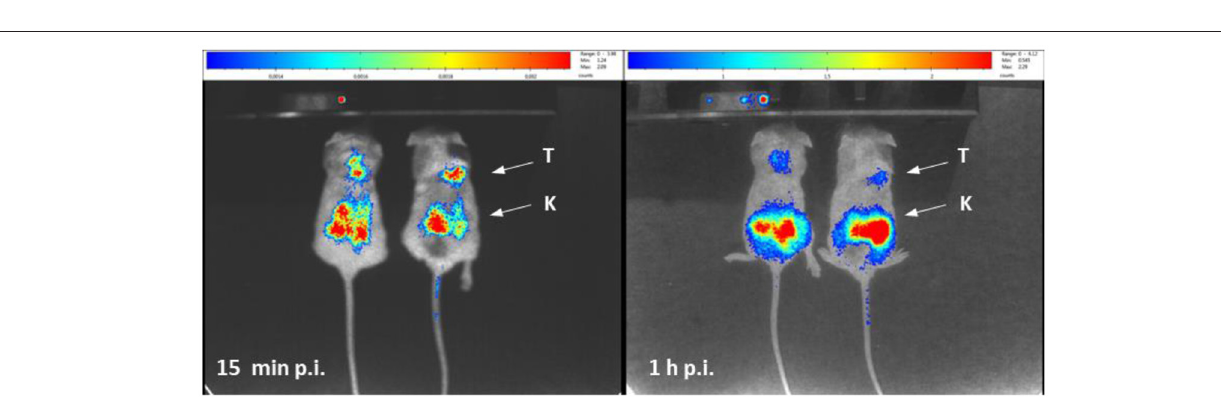
FIGURE 4 | Cherenkov luminescence images at different time points (15min, 1h) of prostate cancer PC3 tumor-bearing mice administered first with AR-PEG4-TCO (1 nmol) and then, after 4h, with [ 90